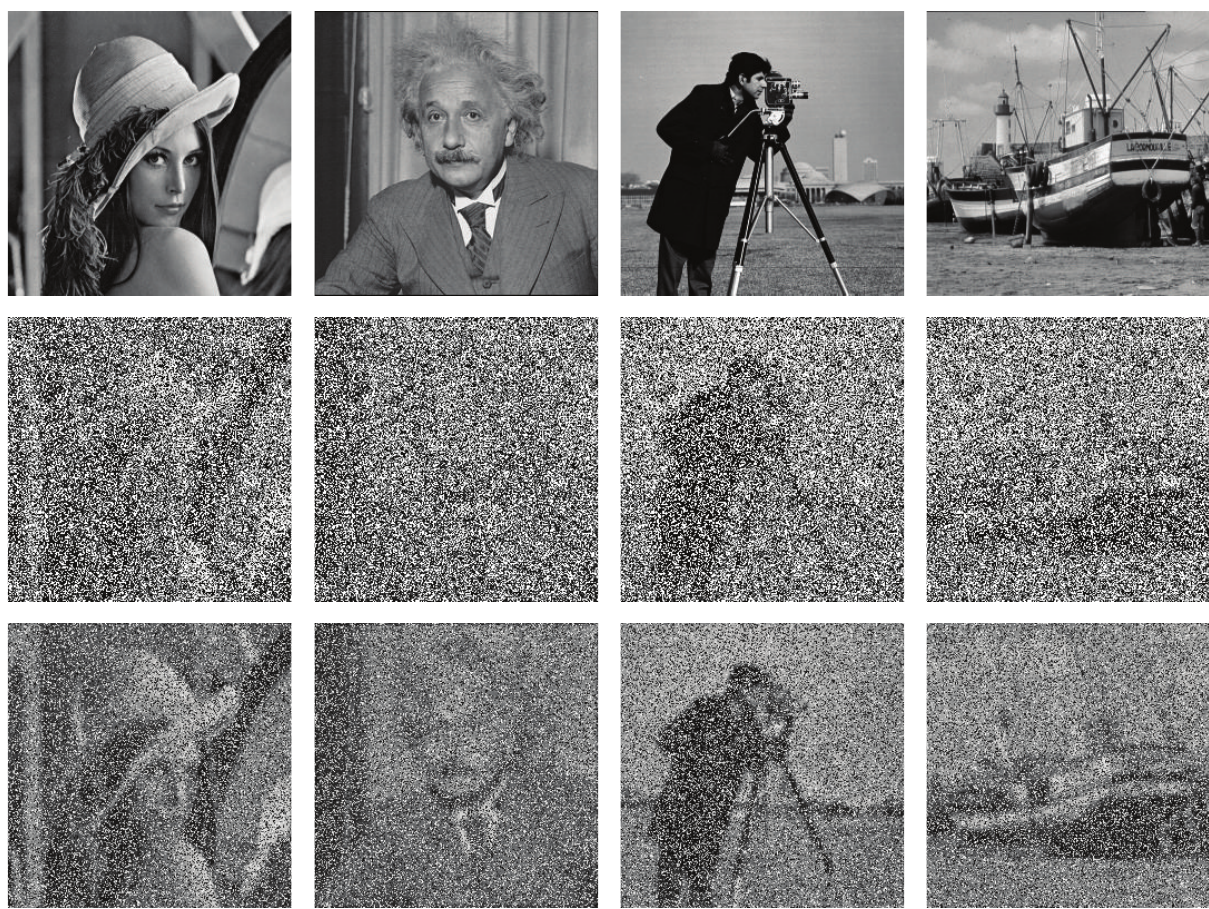
Figure 1: Top: the original images. Middle: Blurred and noisy images by using an out-of-focus kernel with radius 3 and corrupted by salt- and-pepper noise with noise level 𝑠 = 7 0%. Bottom: blurred and noisy images by using an out-of-focus kernel with radius 3 and corrupted by random-valued noise with noise level 𝑟 = 5